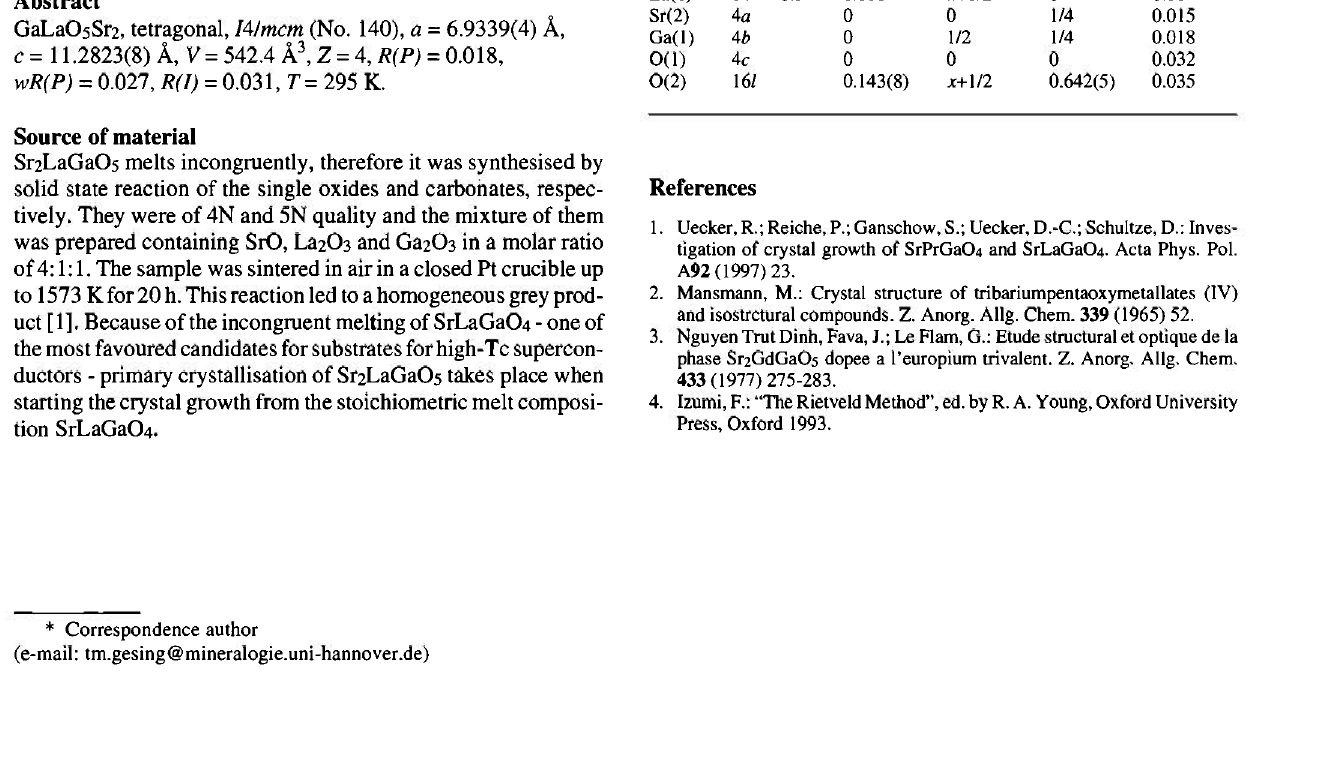
Table 2. Atomic coordinates and displacement parameters (in Ä 2